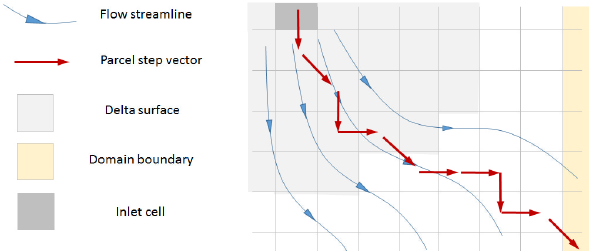
Figure 5. A diagram showing the path of one individual water par- cel compared to smooth flow